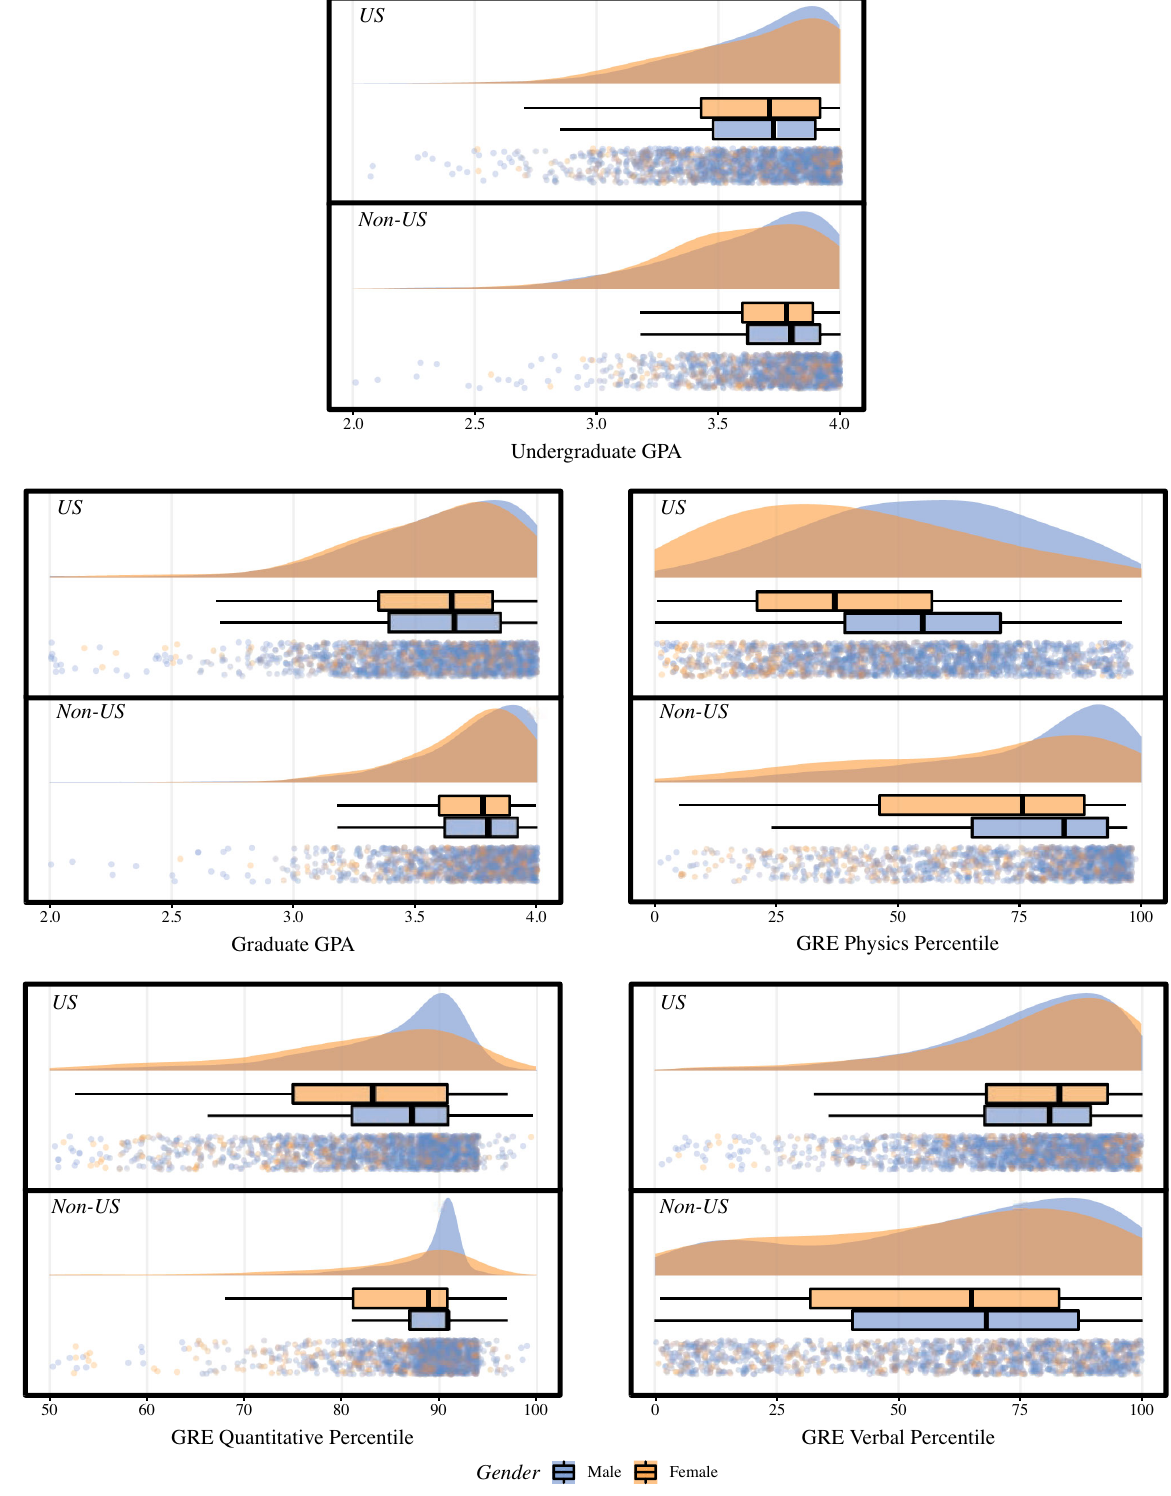
FIG. 1. Distributions of the quantitative metrics included in the data. “ Raincloud plots ” show density plots, boxplots, and scatterplots of the data. We see that despite significant score gaps between U.S. male and female GRE-P test takers, no such gap exists in subsequent GGPA performance. UGPA distributions for male and female applicants are also similar. Code for generating raincloud plots courtesy of Ref. [42]. All figures generated with the R package ggplot2 [43]. Figure themes adapted from Ref.